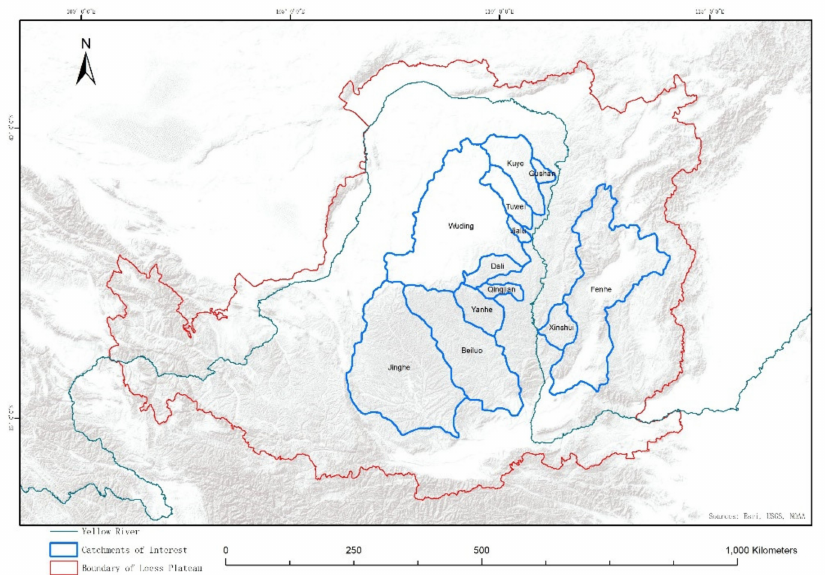
Figure 1. Study Area: the locations of Loess Plateau (red line), catchments (blue line, with catchment names identified), and Yellow River (green line, only the parts within Loess Plateau are shown here) are plotted on a topography basemap, sourced from Esri, USGS, and